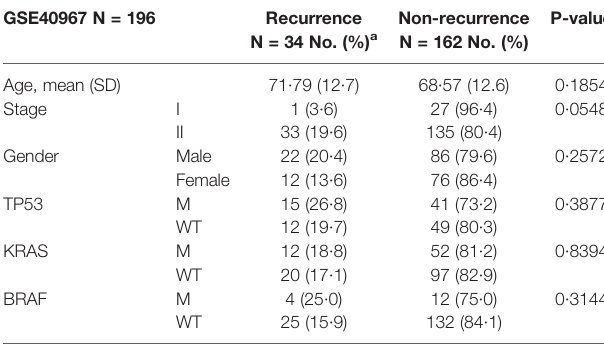
TABLE 2 | Clinical feature